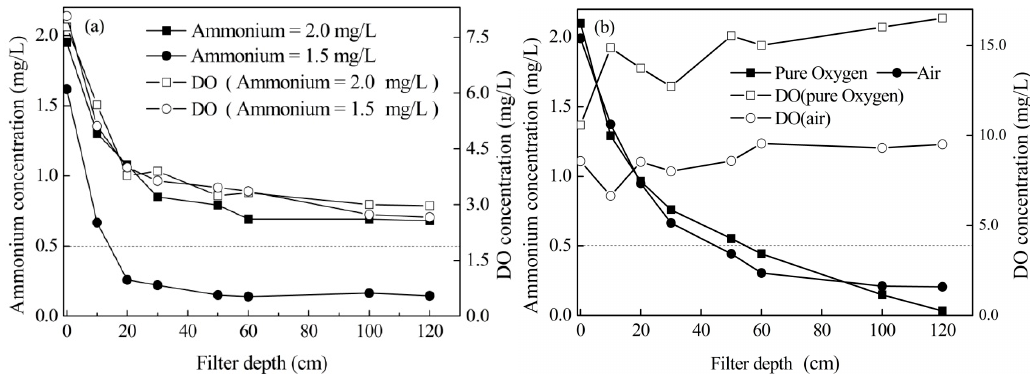
Figure 2. ( a ) Ammonium removal with aeration by water ‐ dropping; ( b ) Ammonium removal with aeration using compressed air and pure oxygen from the bottom of the filter.